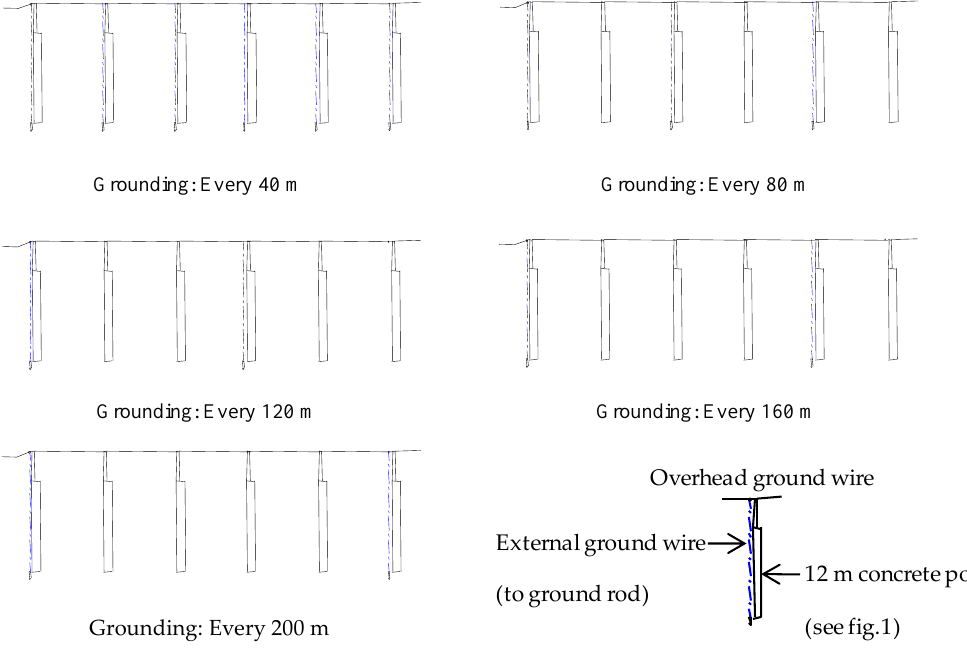
Figure 5. Different grounding distance of overhead ground wire.